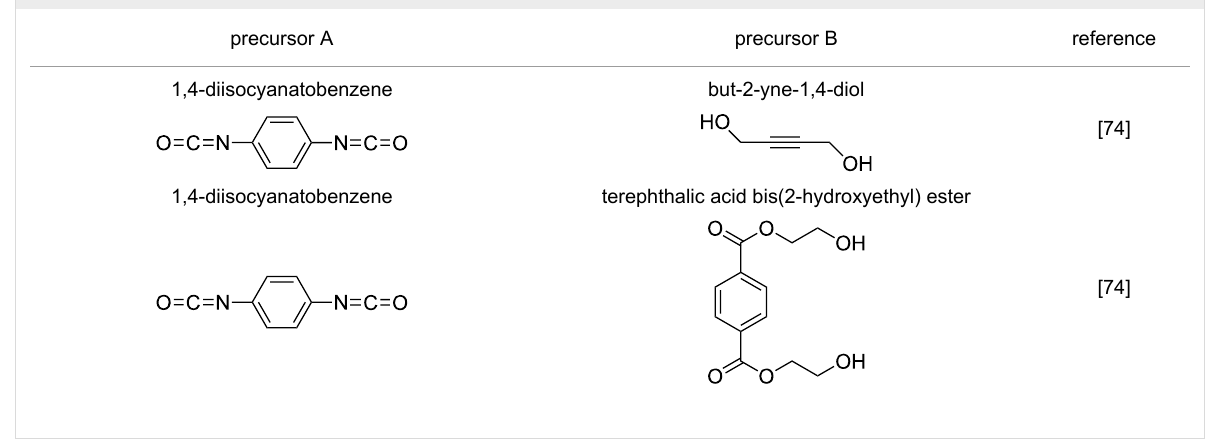
Table 7: Precursors used to deposit polyurethane thin films.